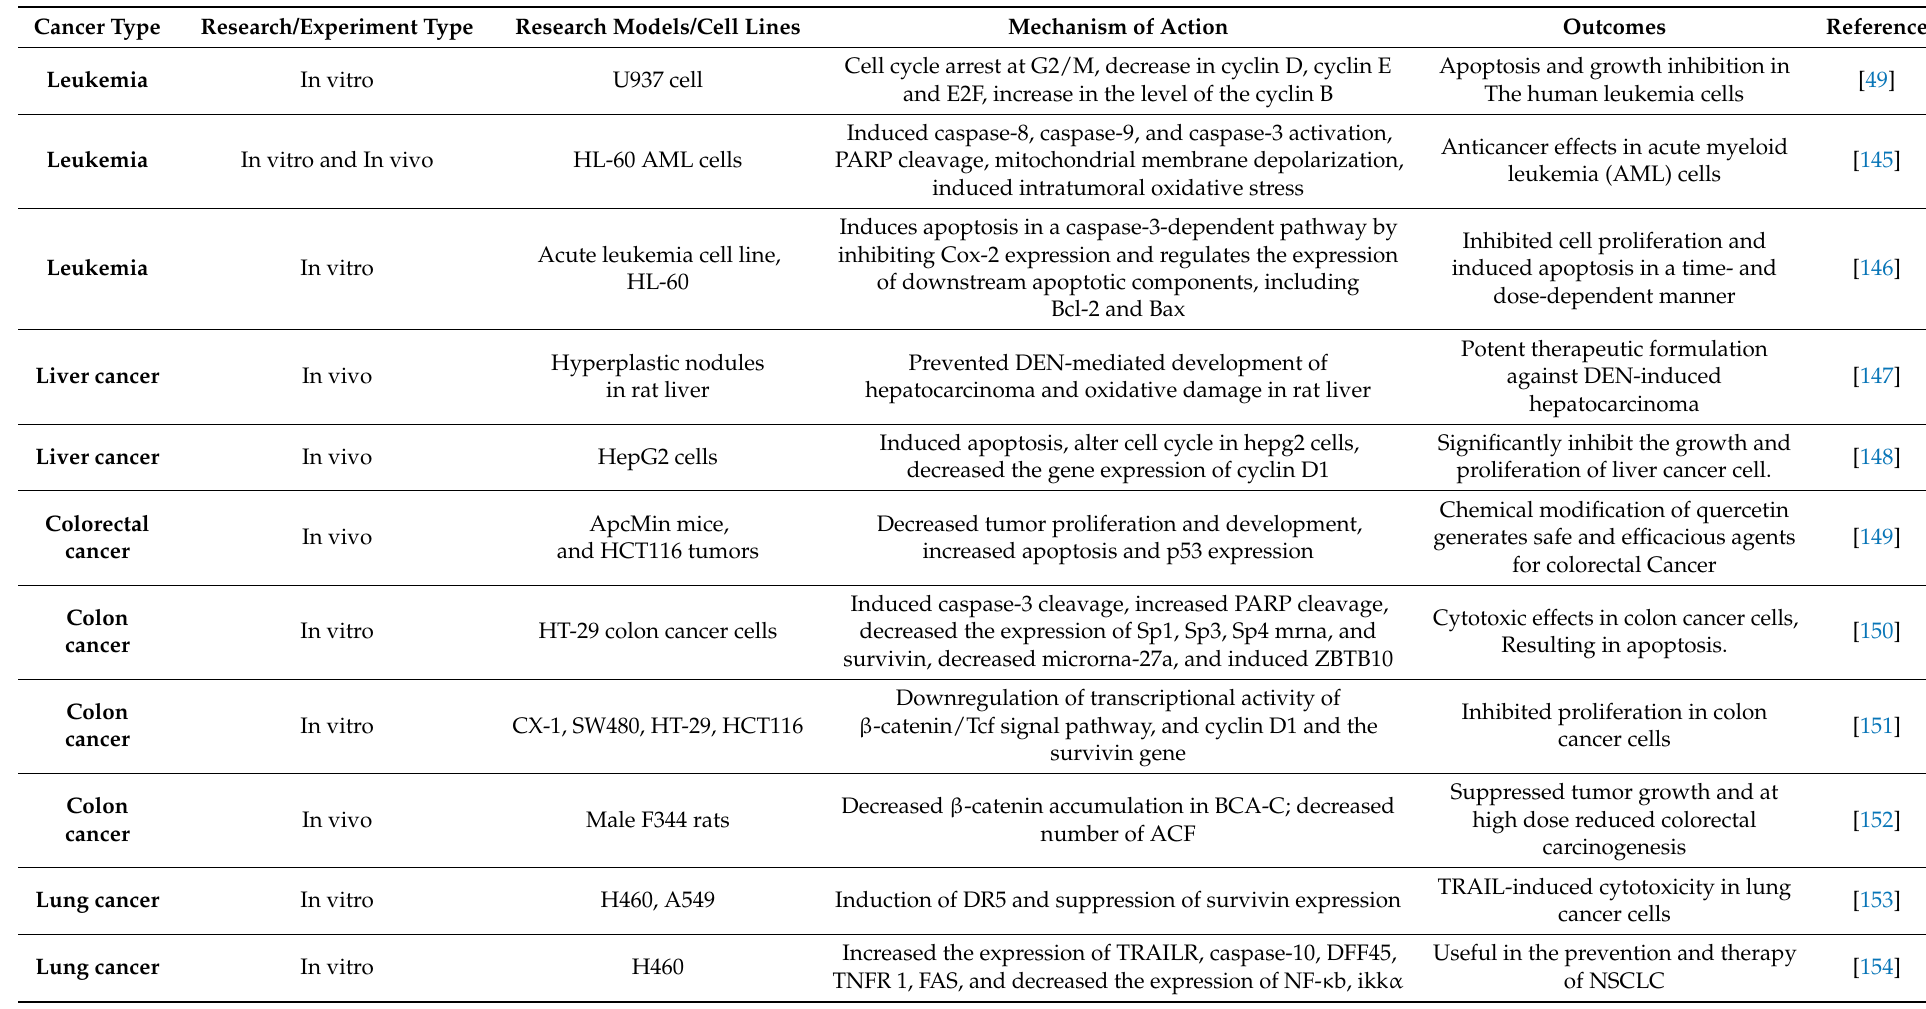
Table 1. Tabular representation of the anticancer potential of quercetin in different cancer